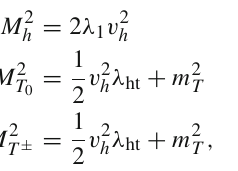
boson pair T ± and one CP-even neutral Higgs boson T 0